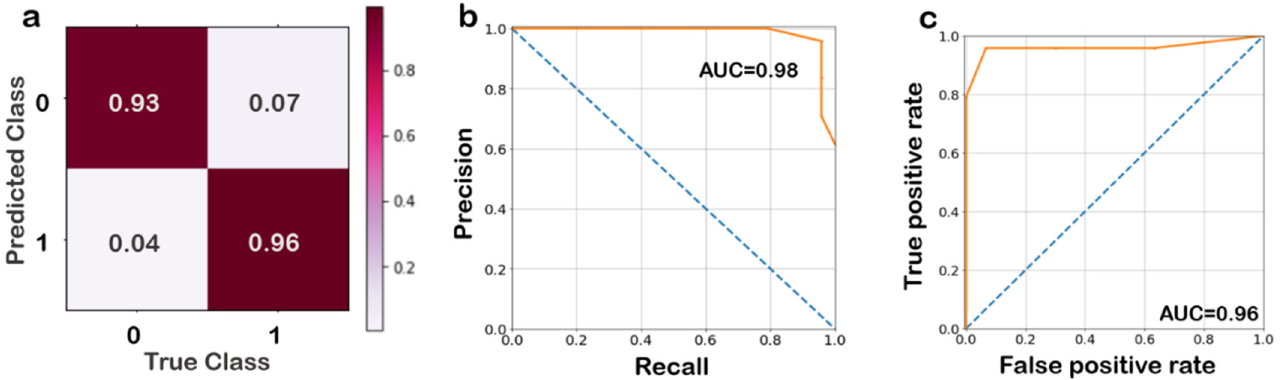
Figure 4. ( a ) Confusion matrix for the random forest classifier, vertical axis is for predicted labels and the horizontal axis states the true labels. The values are ratios of the number of instances predicted to the total instances in the class. ( b ) Precision–recall curve, shown in orange which has an area under the curve of 0.98 for the whole dataset, ( c ) receiver operating characteristic (ROC) also shown in orange for the test dataset, which plots the true positive rate against the false positive rate. The area under the curve (AUC) is 0.96. The dashed blue line across the diagonal shows 50% accuracy.